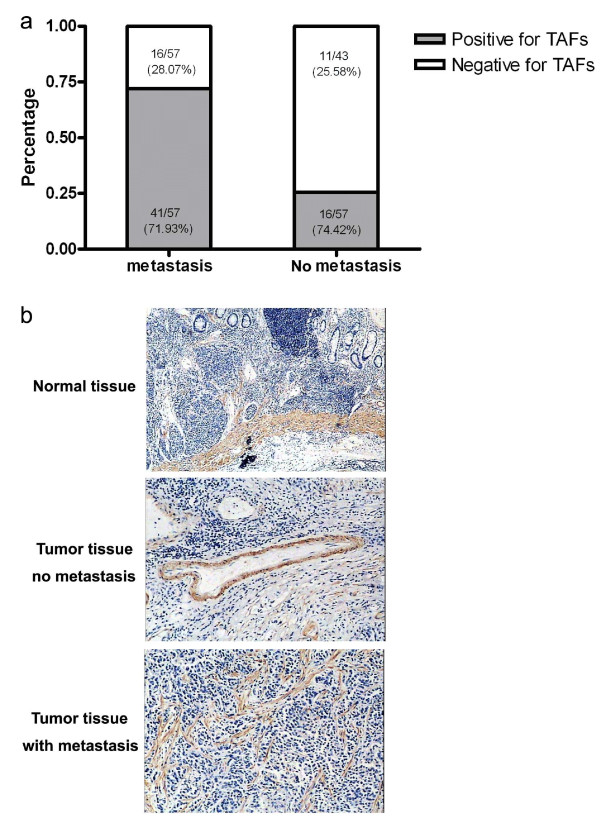
The percentage of tumor specimens which was positive or negative for CAFs' prevalence in the group of patients with or without tumor metastasis. The tumor specimens were grouped according to whether or not the gastric cancer patients had tumor metastasis (whatever lymph node metastasis, distant metastasis or organ metastasis). And the percentage of the specimens which was positive (grade - or + according to immunochemical staining) or negative (grade ++ or +++ according to immunochemical staining) for CAFs' prevalence was analyzed (a). And the immunochemical staining of α-SMA was shown in normal gastric tissue, gastric cancer tissue without metastasis and gastric cancer tissue with metastasis (b).